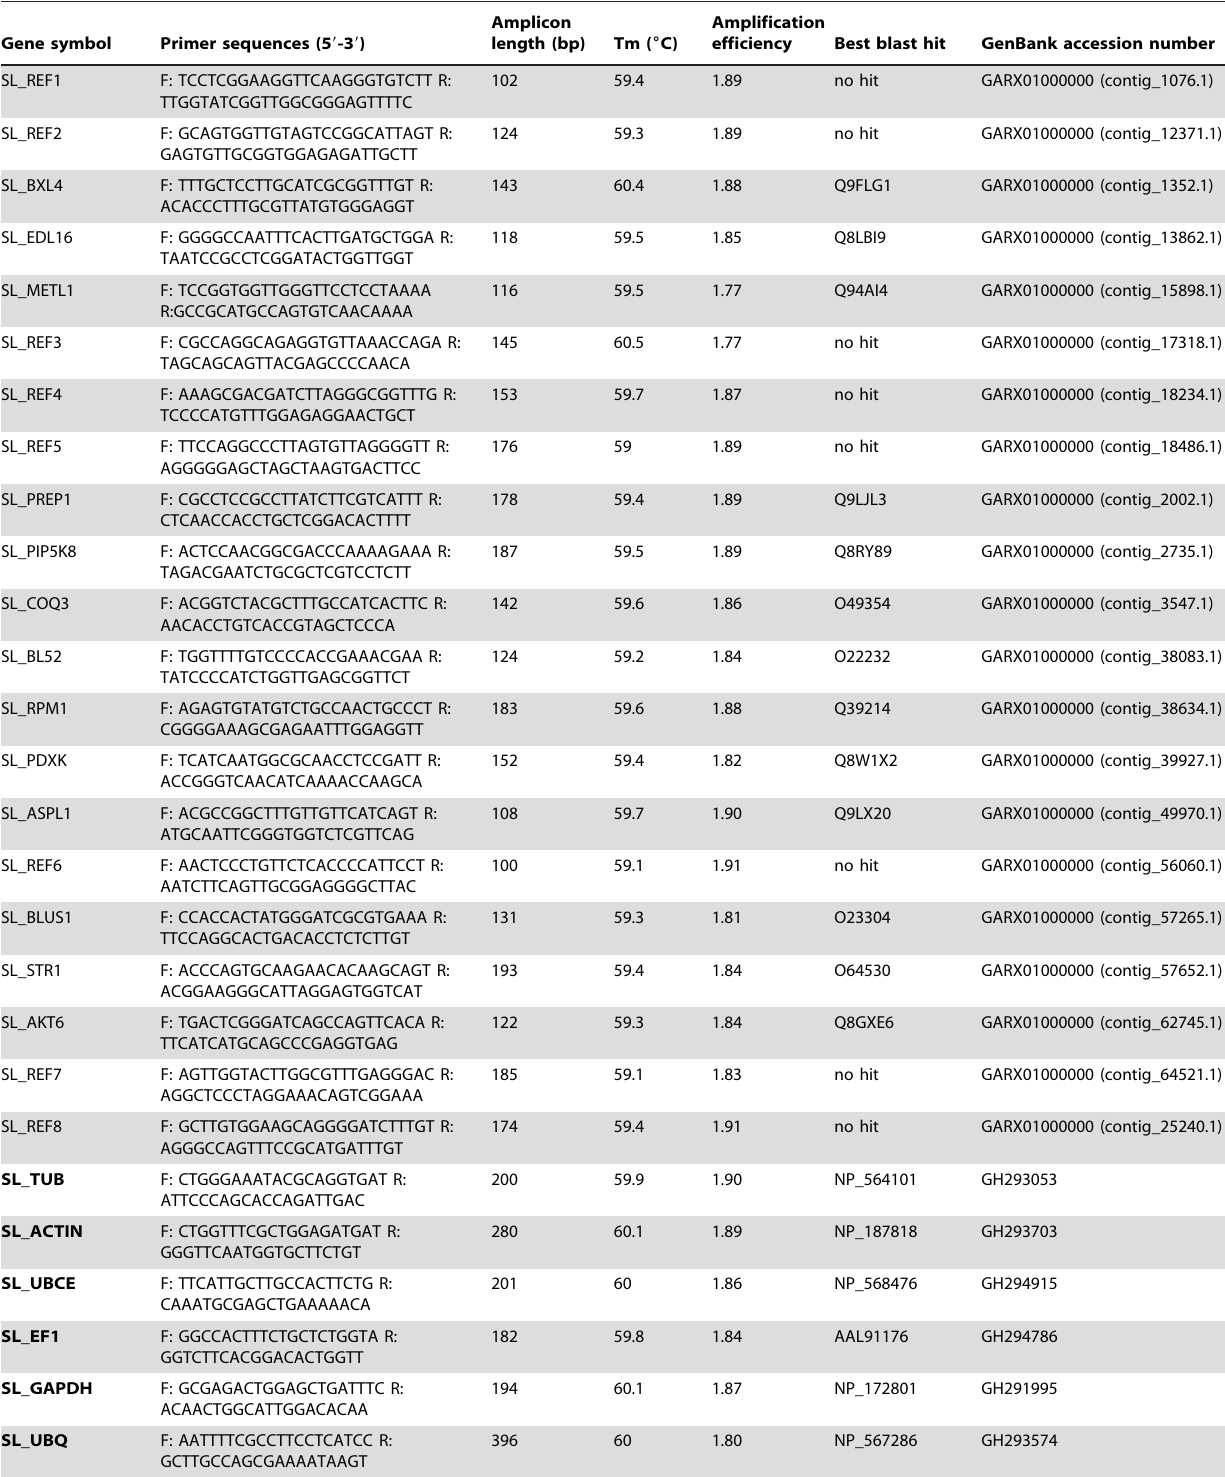
Table 1. Gene names, primer sequences, amplicon characteristics of the S. latifolia candidate reference genes, accession numbers of the protein with the best blast hits in A. thaliana and accession numbers of sequences that were used to design the assays are